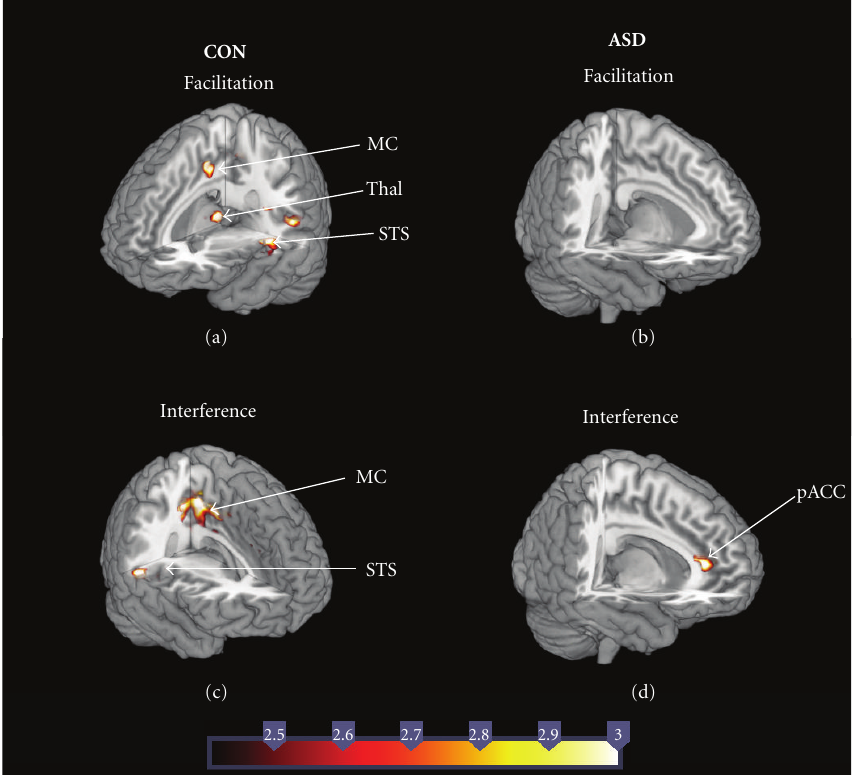
Figure 2: Regions showing di ff erences between left and right amygdala connectivity in control (CON) and ASD children during facilitation (Congruent > Neutral) and interference (Incongruent > Neutral). In control children, greater right than left amygdala was observed during facilitation (a) but greater left than right amygdala connectivity was observed during interference (c). ASD children showed greater right than left amygdala connectivity during both facilitation (b) and interference